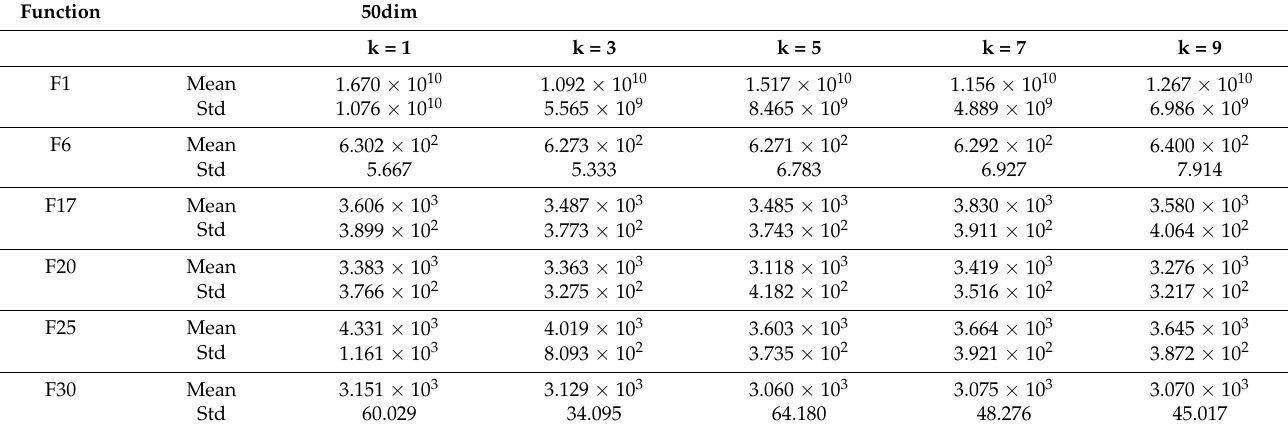
Table 3. The 50-dimensional function test.